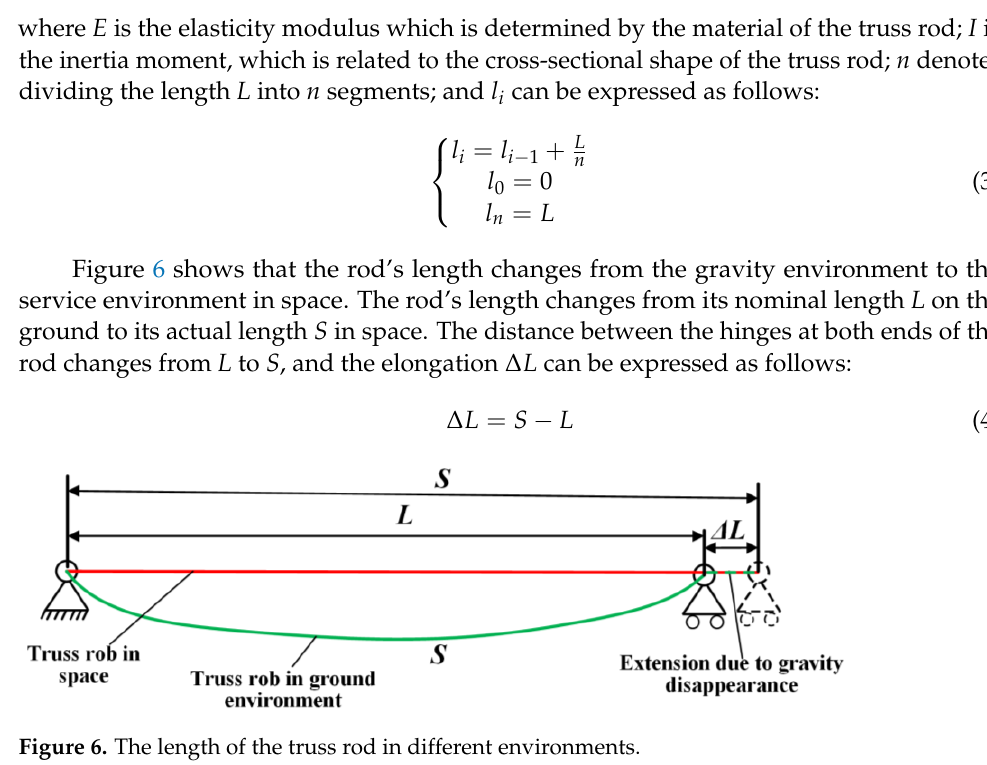
Figure 5. Analysis of force and deformation of truss rod.